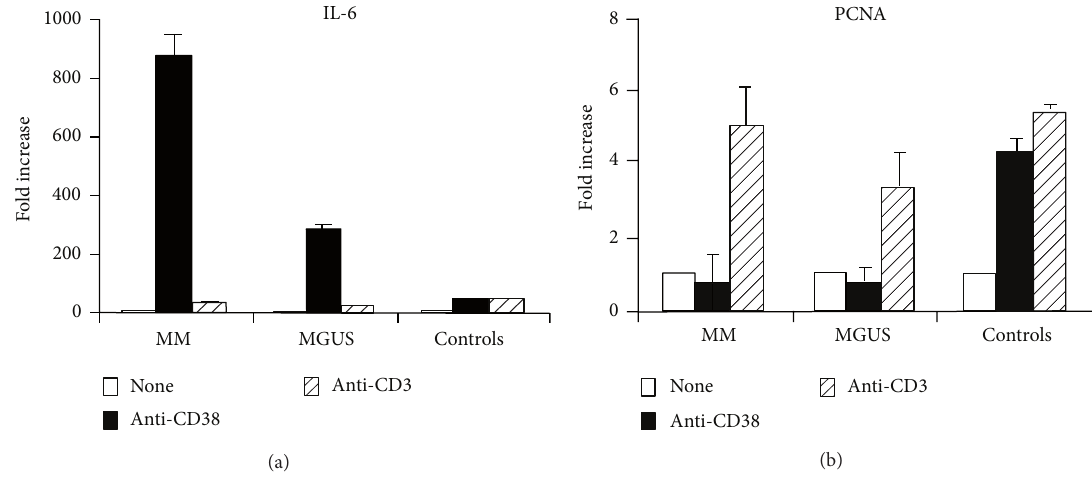
Figure 2: IL-6 and PCNA induction by CD38 molecules engagement in PBMC obtained from MM, MGUS patients, or healthy individuals. (a) PBMC (1 × 10 6 /mL) obtained from MM, MGUS patients, or healthy controls were cultured in the presence of agonistic anti-CD38, anti- CD3, or unstimulated (none). Taqman Real Time quantitative RT-PCR for IL-6 gene expression was performed at 18hours time-point. mRNA transcript levels were expressed as fold increase over the unstimulated PBMC. (b) PBMC (1 × 10 6 /mL) obtained from MGUS, MM patients, or healthy individuals were cultured in the presence of agonistic anti-CD38, anti-CD3, or unstimulated (none). Taqman Real Time quantitative RT-PCR for PCNA gene expression was performed at 18hours time-point. mRNA transcript levels were expressed as fold increase over the unstimulated PBMC. For further technical details, see